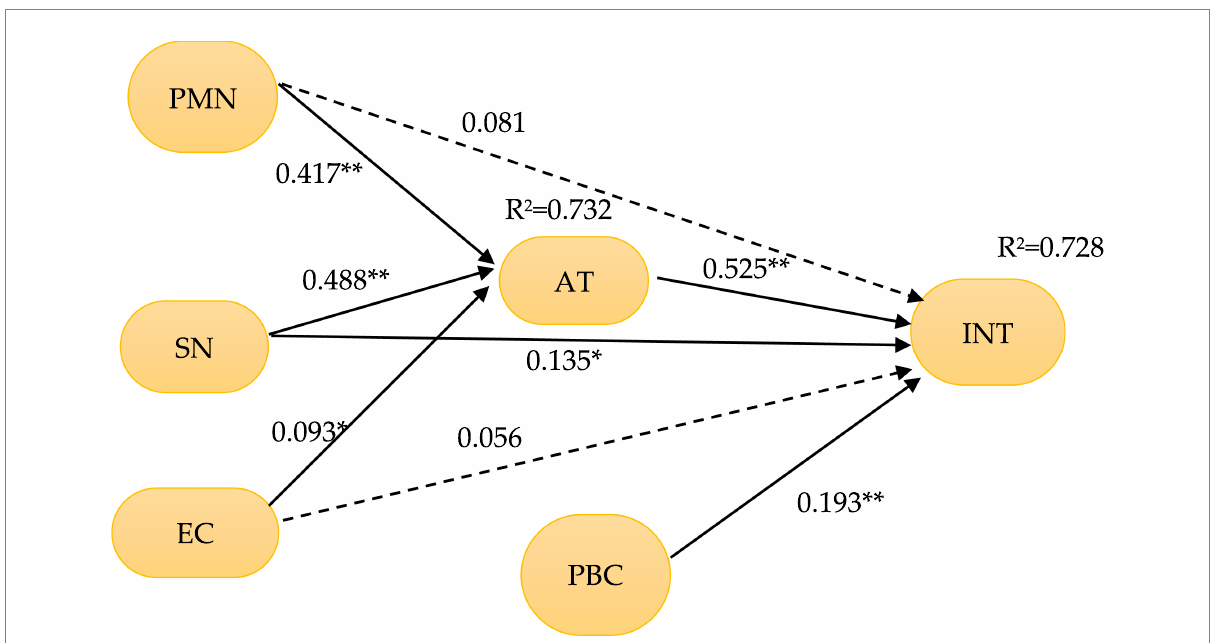
FIGURE 3 Measurement and structural model. (1) PMN, personal moral norms; EC, environmental concern; AT, attitude; SN, subjective norms; PBC, perceived behavior control; INT, intention; (2) a solid line represents a significant path, and a dashed line represents an insignificant path; (3) * p < 0.05, ** p < 0.01.